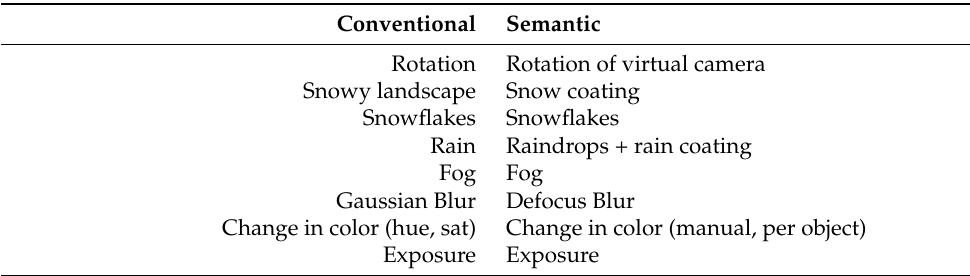
Table 1. Matched augmentation categories for the two augmentation